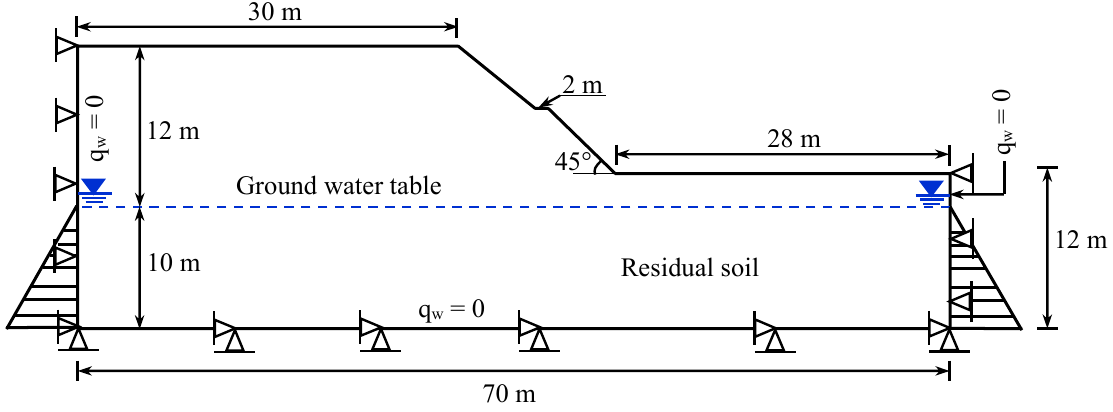
Figure 6. Hydraulic and mechanical boundary conditions of soil slope at Pohang site [21].